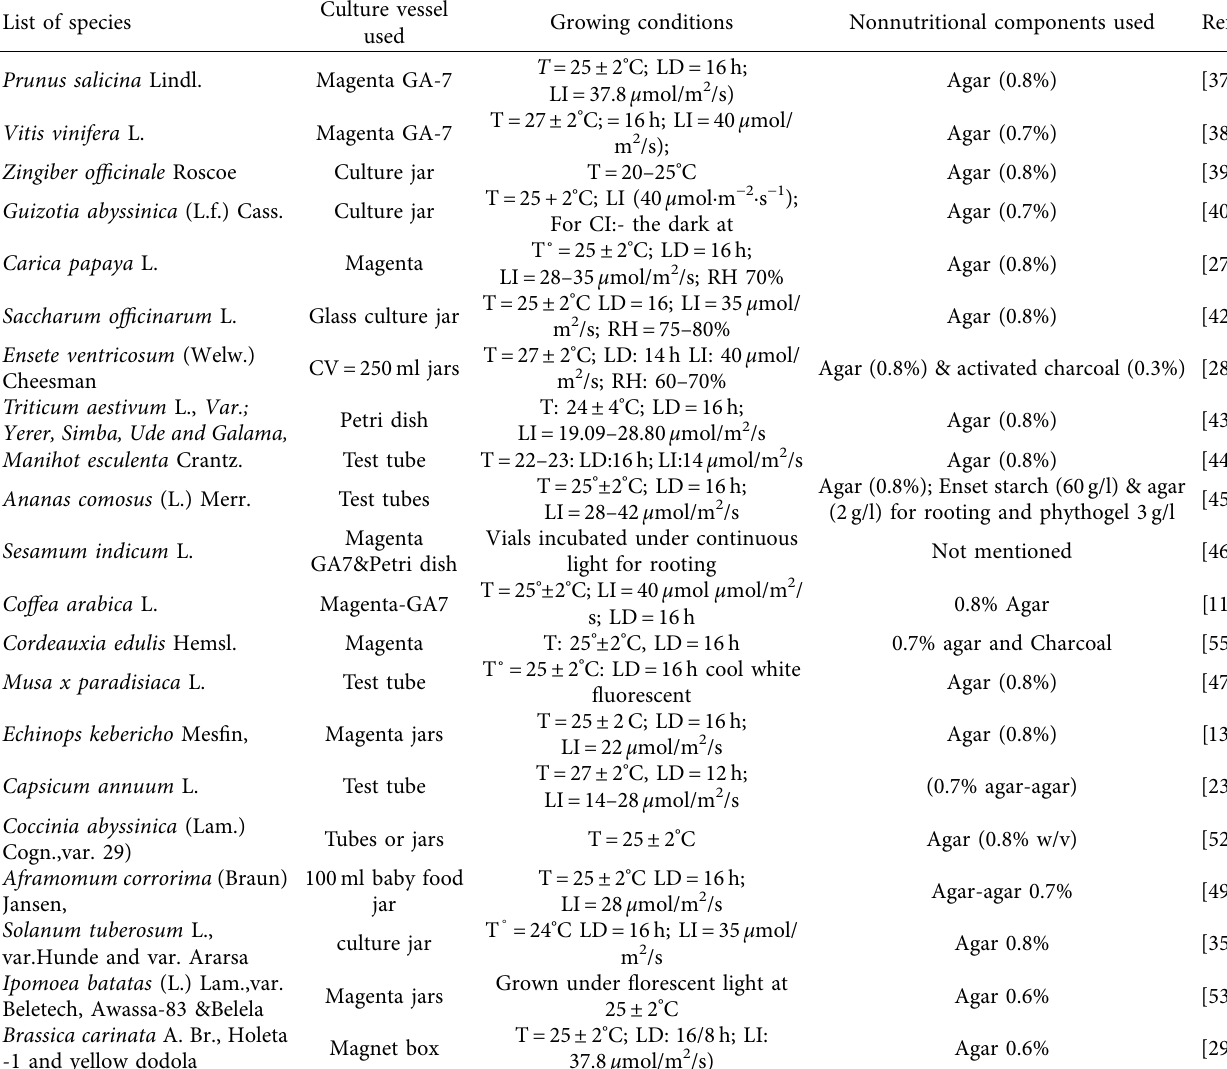
Table 1: List of plant species studied in Ethiopia, published and reported so far, culture vessels, in vitro growth and regeneration conditions, and nonnutritional components used.